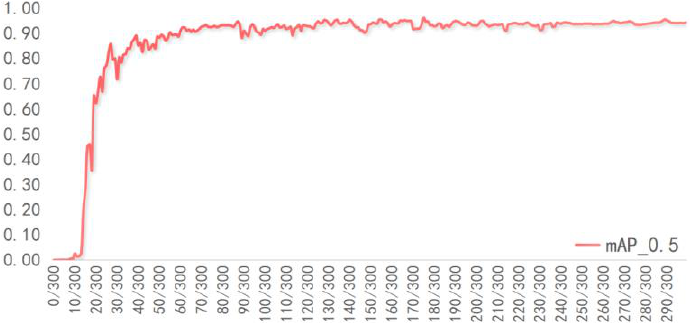
Figure 12. Visualization of the training results.